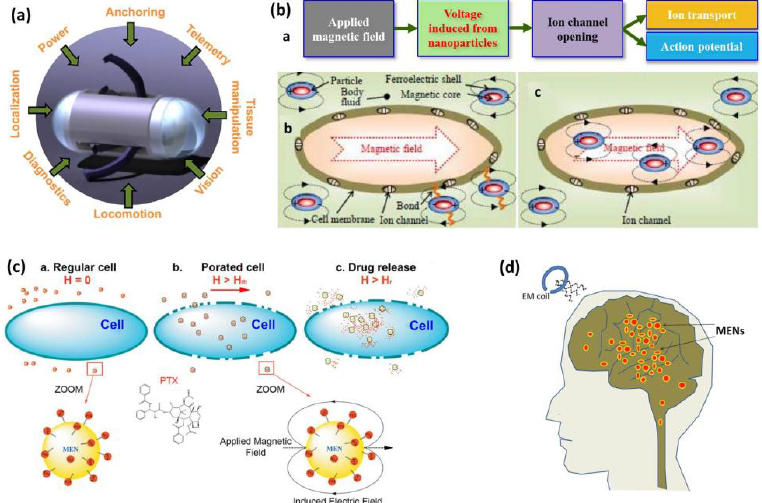
Figure 16. ( a ) Key functionalities that complement the wireless capsule endoscopes [73]; ( b ) Illustration of possible mechanisms of stimulation of ion channels: a chain of actions triggered by the applied magnetic field pulses, external and internal stimulation by uptaken nanoparticles [108]; ( c ) MENs as field-controlled nano-electroporation sites to let the drug through the cancer cell membranes [109]; ( d ) Illustration of the deep brain stimulation approach [110].